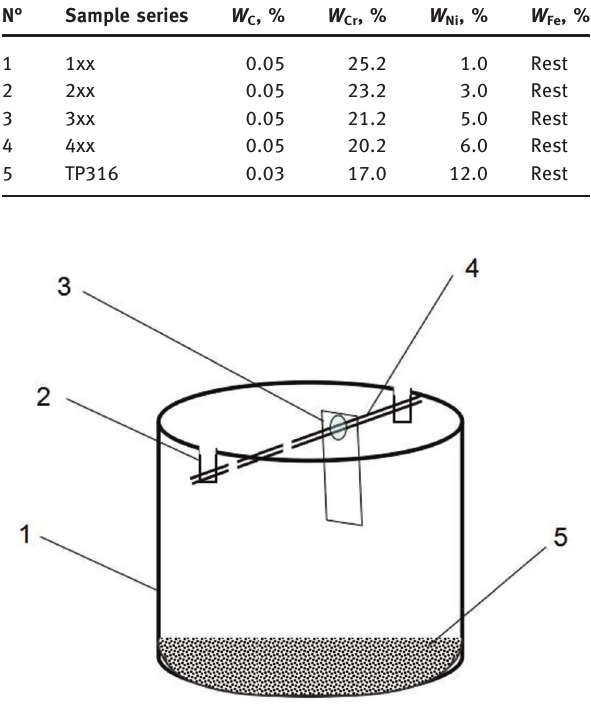
Figure 1: Schematic view for sample arrangement of high-temperature corrosion experiment.